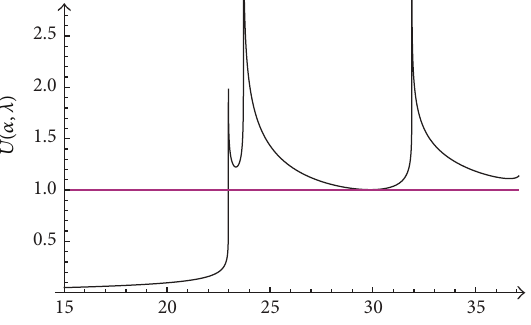
Figure 7: The graph of the function 𝑈(𝛼, 0.01824) .